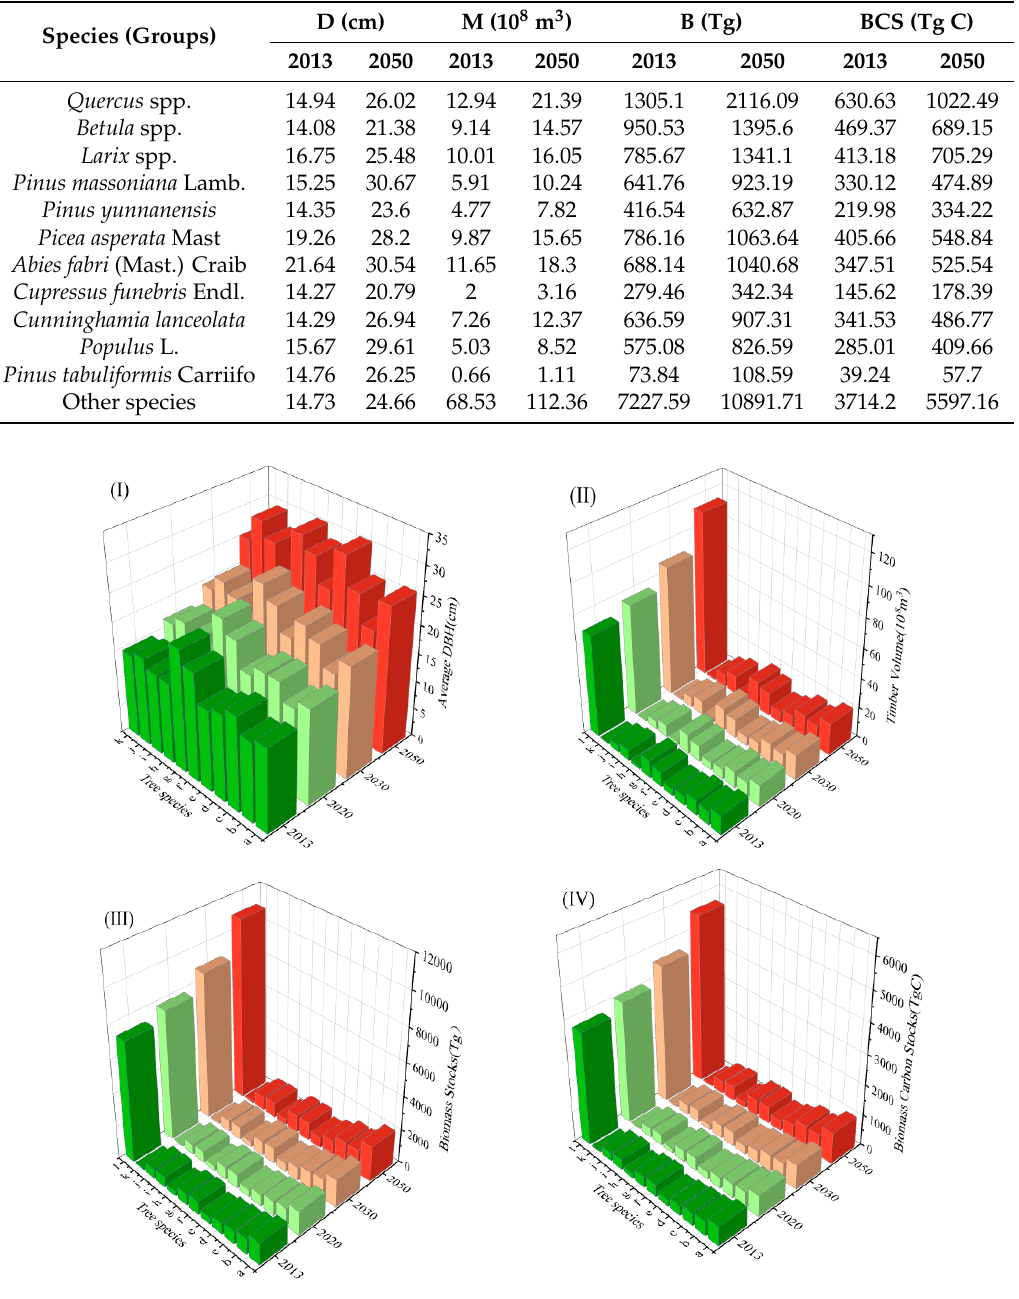
Figure 4. DBH, volume, biomass, and BCS of Chinese forests from 2013 to 2050. Meaning of each